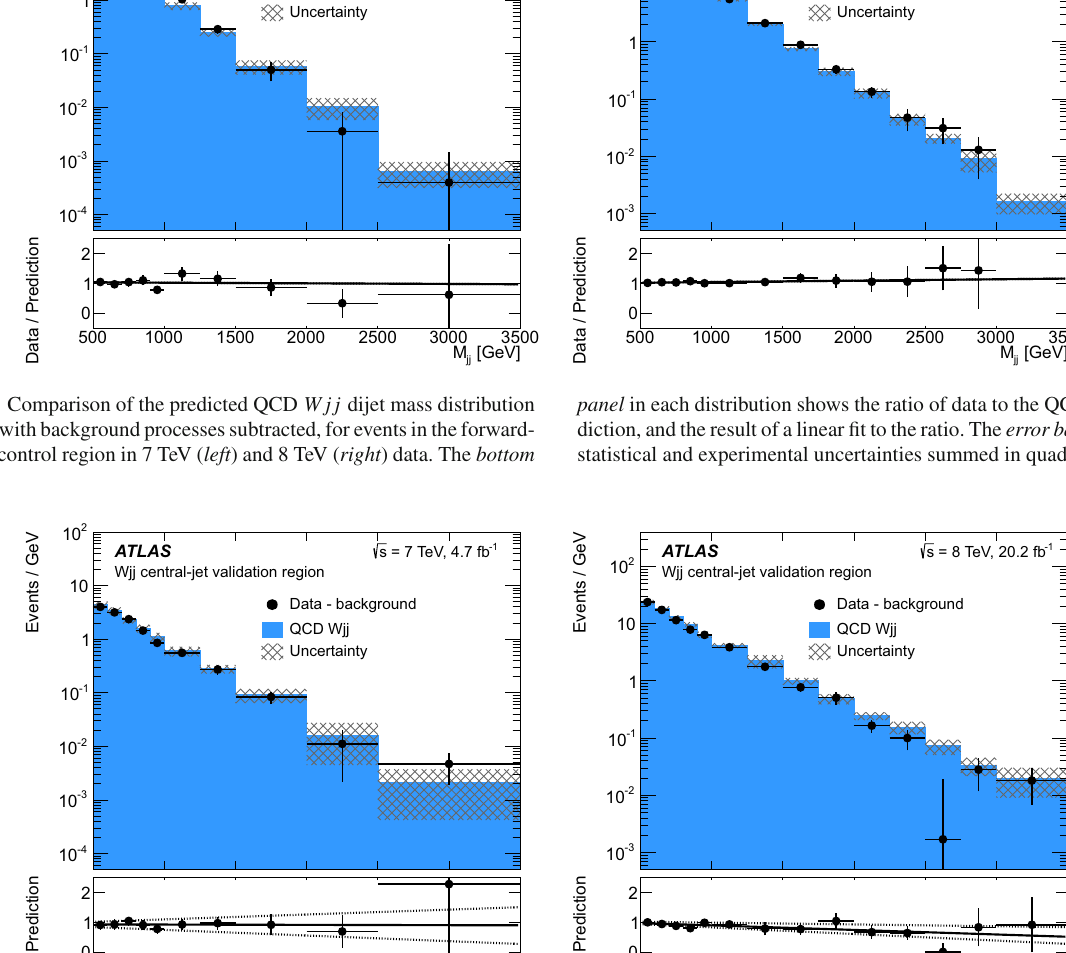
tion, and the result of a linear fit to the ratio ( solid line ). The error bars represent statistical and experimental uncertainties summed in quadra- ture. The dotted lines show the fit with slope adjusted up and down by statistical and experimental